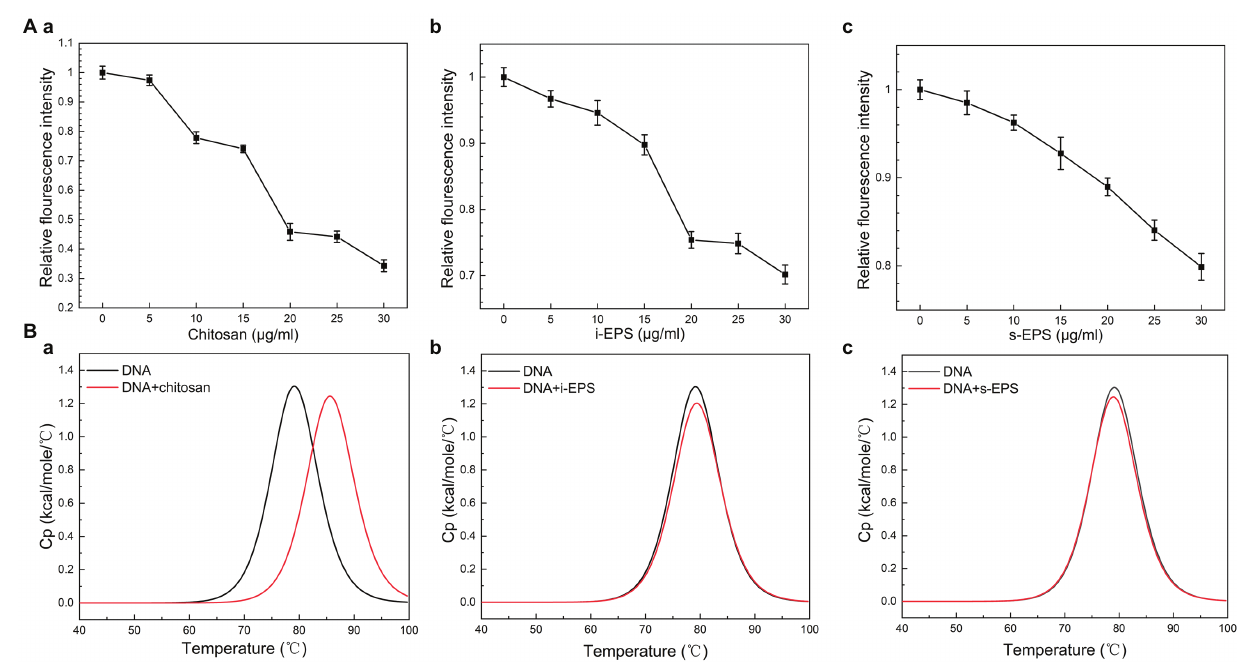
FIGURE 5 | The role of electrostatic force in the DNA-EPS interactions. (A) Competitive displacement of EB bond to DNA by chitosan (a), i-EPS (b), and s-EPS (c) at pH 7.5. The fluorescence intensity was monitored using an excitation and emission wavelength of 510 and 600 nm. (B) Differential scanning calorimetry (DSC) curves for thermal melting of DNA in the presence of chitosan (a), i-EPS (b), and s-EPS (c). The DSC melting data was generated by subtracting the buffer response and normalized to the concentration of